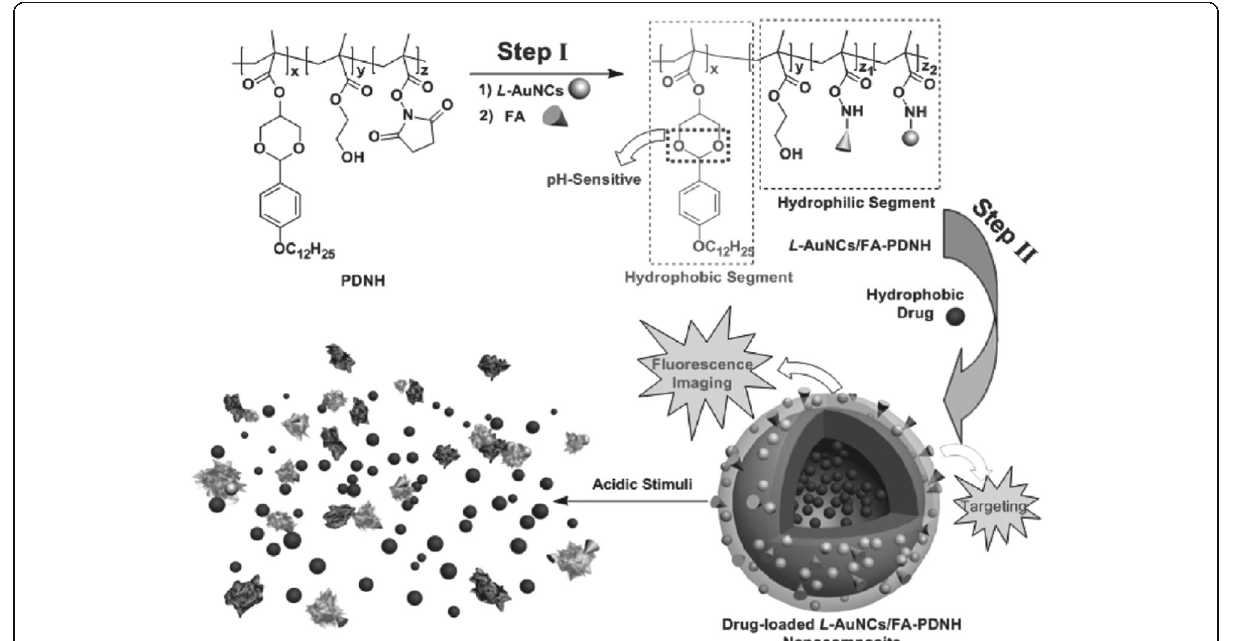
Fig. 6 Fabrication of L-AuNCs/FA-PDNH nanocomposite for imaging and therapy [88]